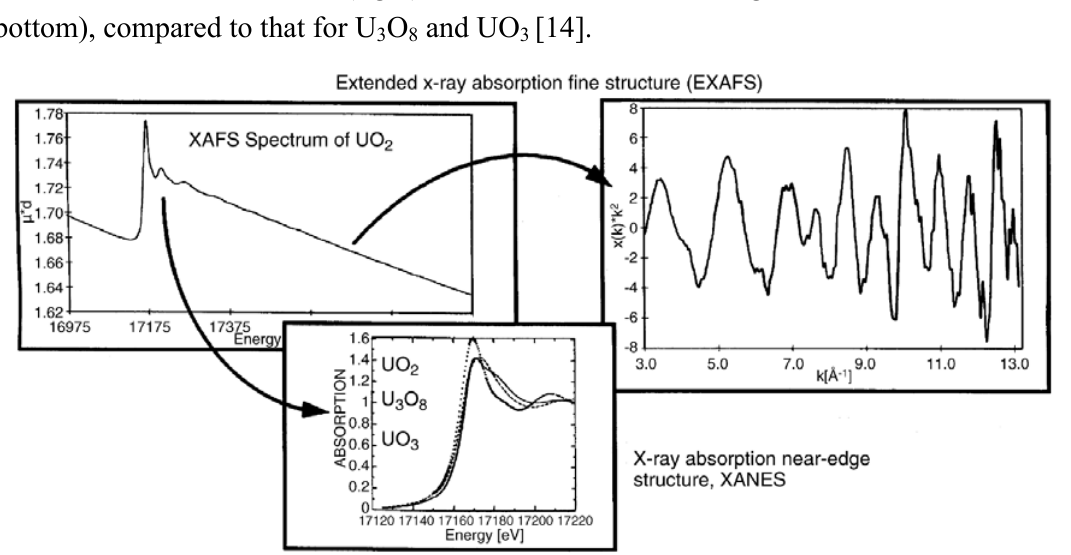
Figure 12. Raw data U L extracted from the raw data (right) and the normalized, background subtracted XANES (bottom), compared to that for U